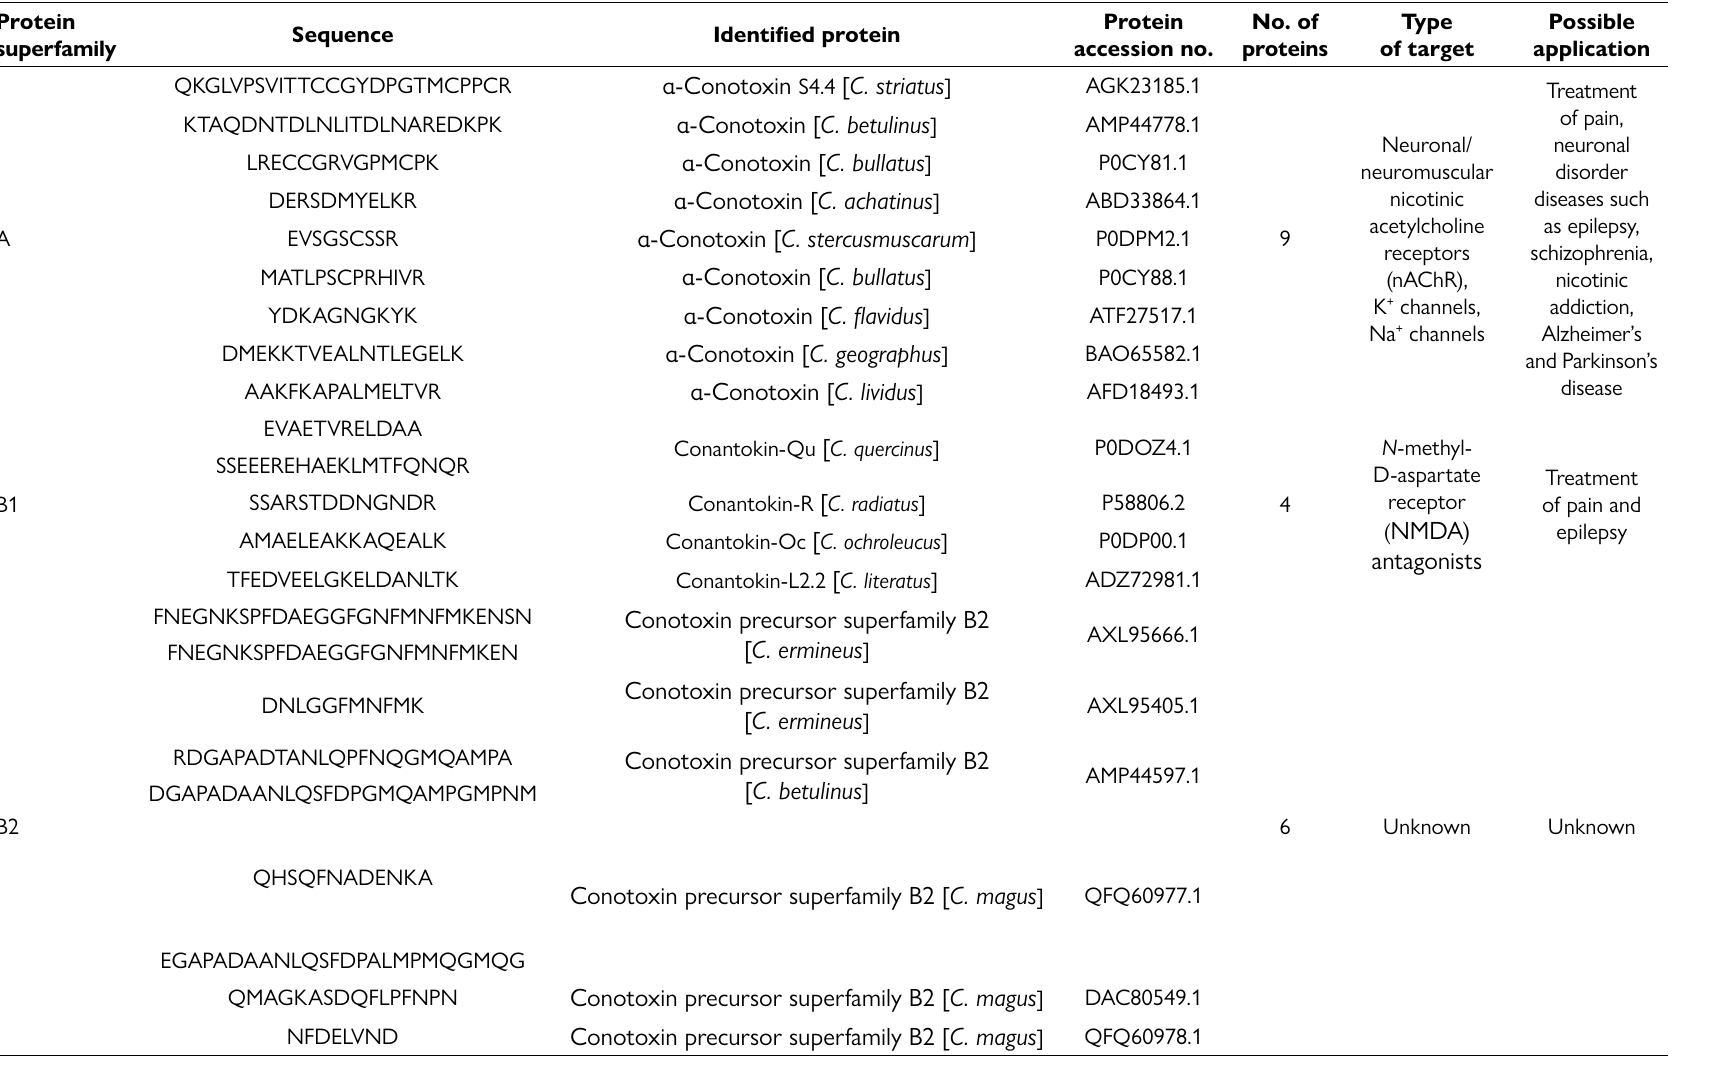
Table 1. List of identified conotoxin proteins in the venom of Egyptian C. taeniatus with their corresponding gene superfamilies, type of targets and possible applications . Protein Sequence Identified protein superfamily